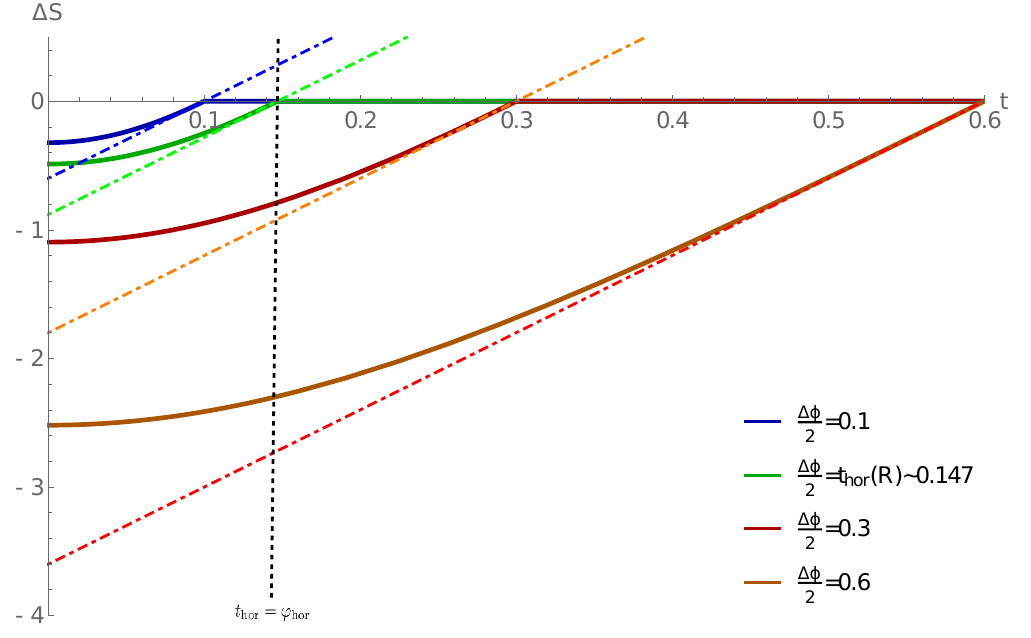
Figure 18 . Evolution of HEE of segments which probe the interior and do not probe the interior. the fundamental domain of the topological identi(cid:12)cation. Because of this and the shape of the identi(cid:12)cation wedge relative to the image geodesics (see (cid:12)gure 9), the image